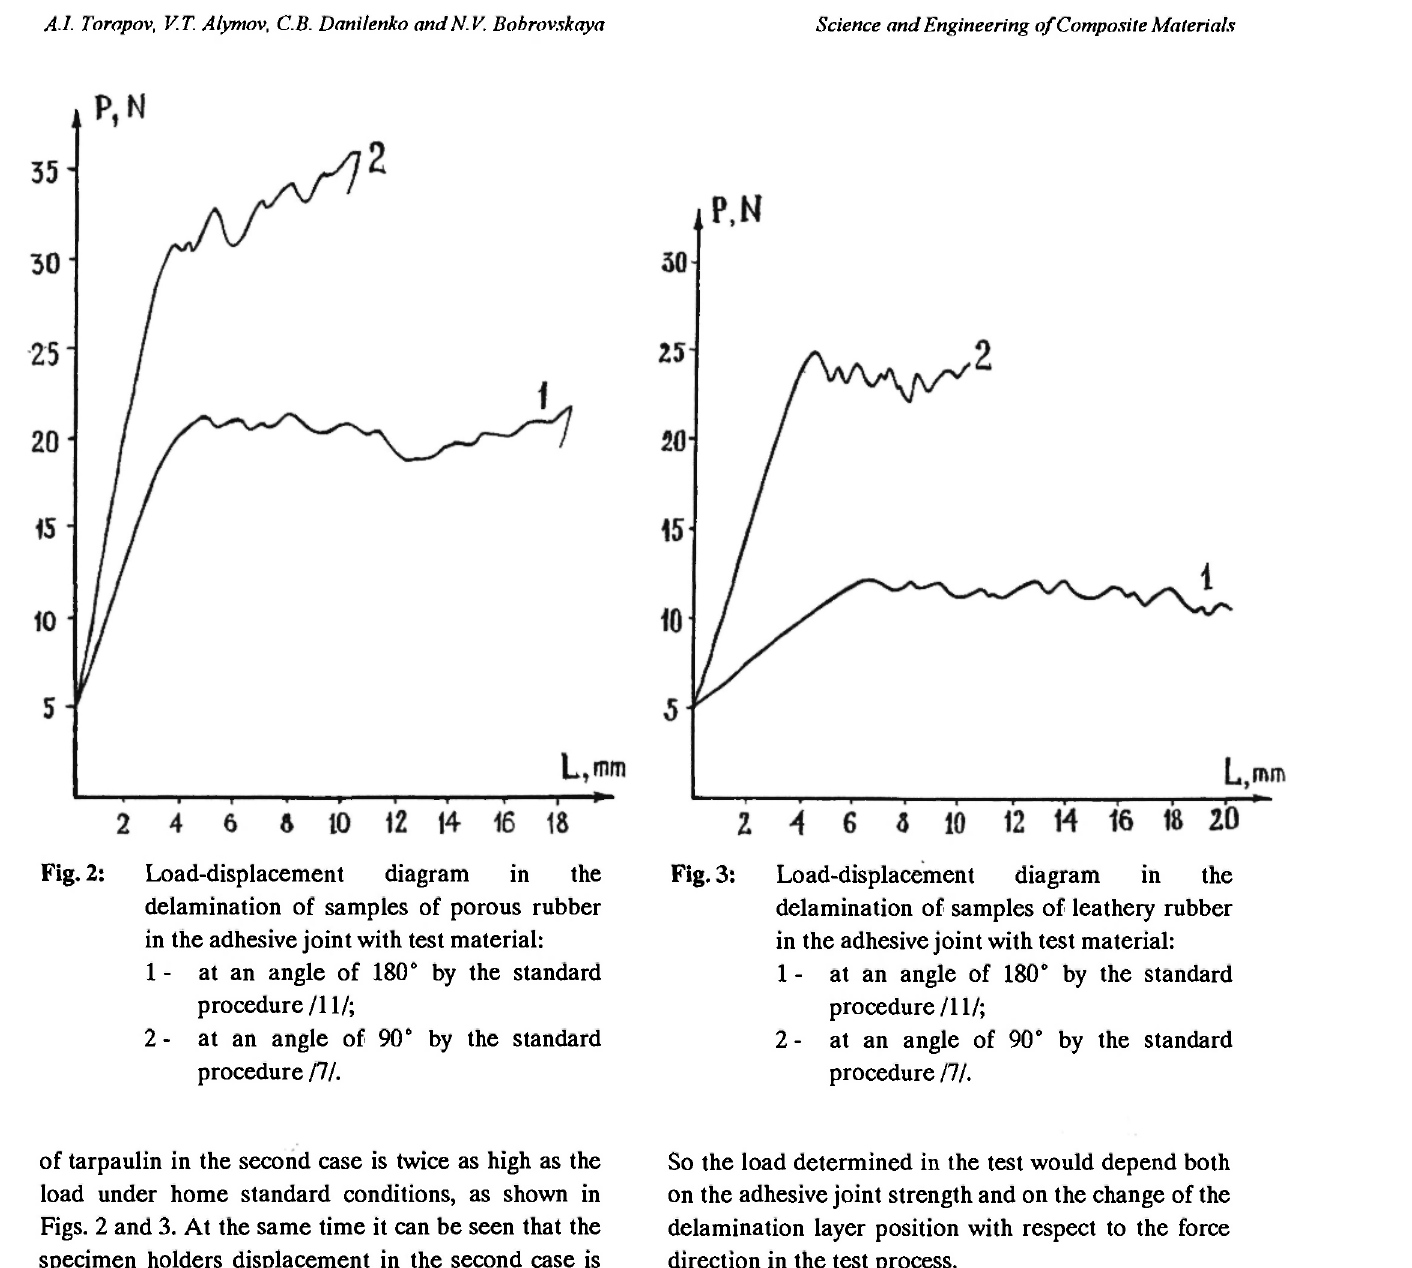
Fig. 3: Load-displacement diagram in the delamination of samples of leathery